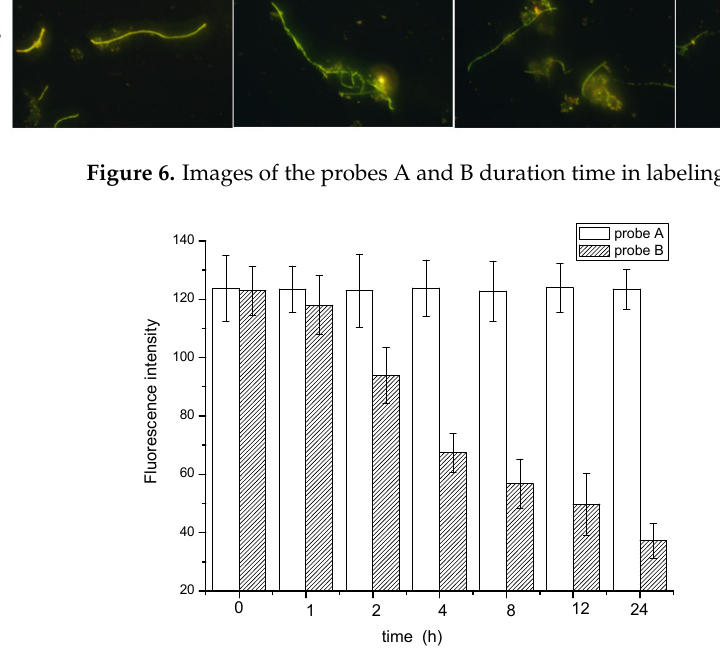
Figure 7. The mean fluorescence intensity of different duration time.